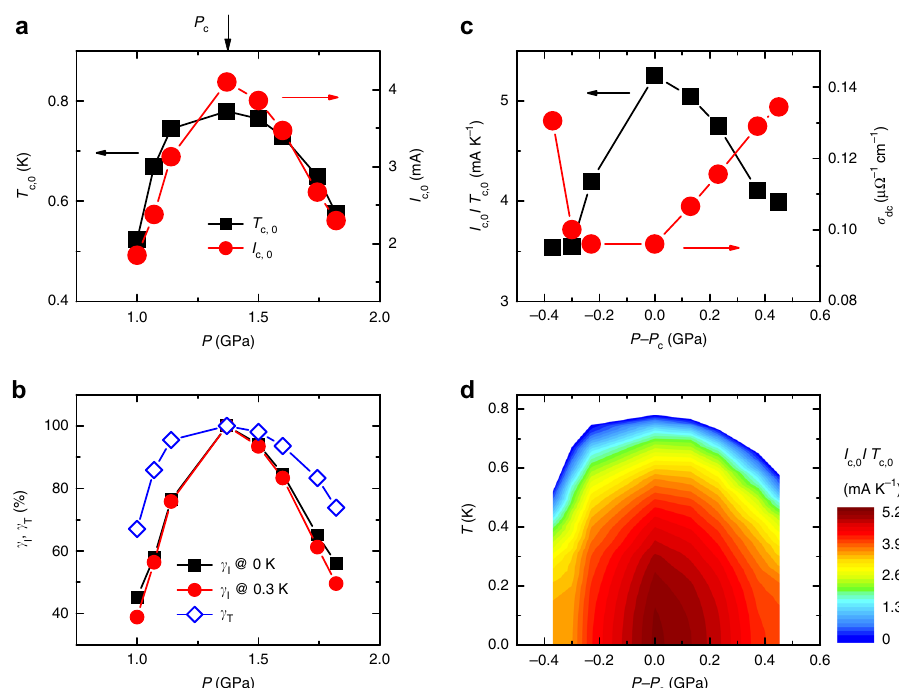
I T c,0 and c,0 for SnRh115 under pressure. The fractions are de